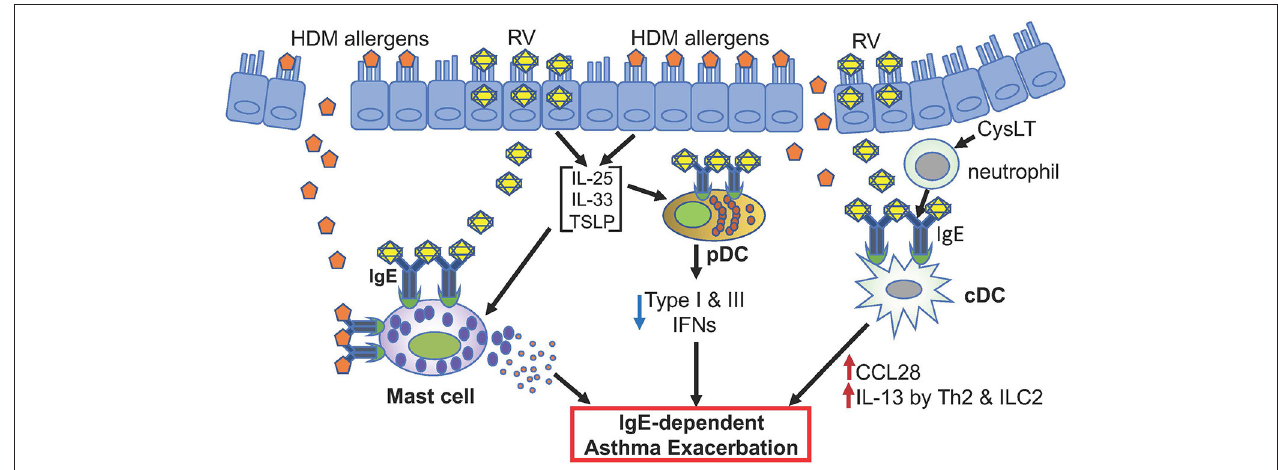
FIGURE 1 | Hypothetical model of RV-induced asthma exacerbation. Only potential events involving IgE and Fc ε RI are depicted. Allergens such as HDM and rhinovirus antigens likely activate mast cells. pDCs highly expressing Fc ε RI in asthmatics may produce reduced levels of type I and type III IFNs when infected with rhinovirus. cDCs with high Fc ε RI expression may produce CCL28 that recruits IL-13-producing Th2 and ILC2 cells. These different cells likely contribute to RV-induced asthma exacerbation.